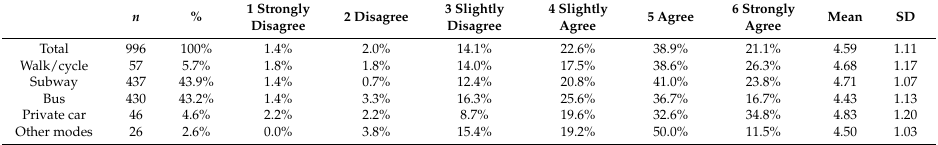
Table 2. Pattern of daily transport and level of perceived safety.